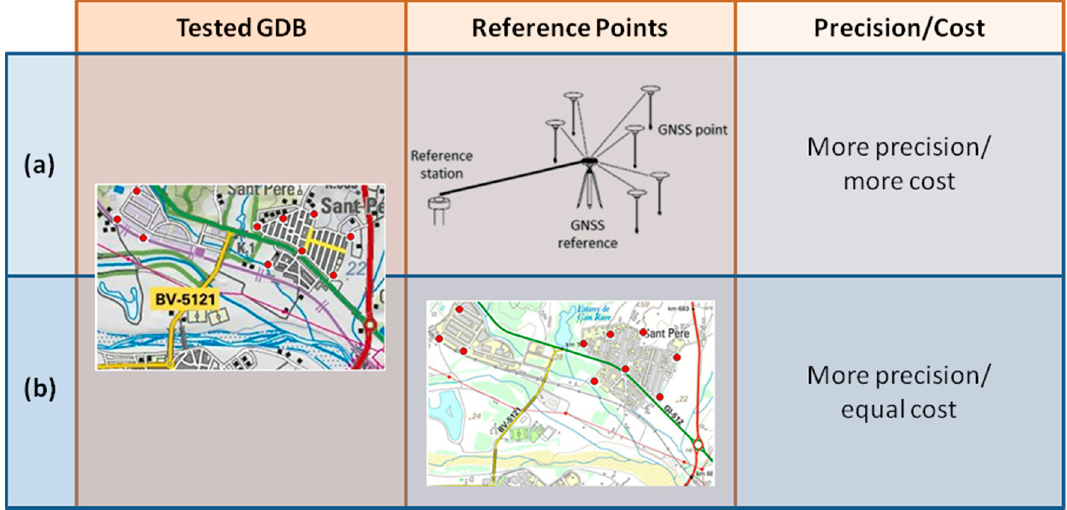
Figure 1. ( a ) Traditional points-based methods of positional quality assessment and ( b ) the new approach based on automated positional assessment. GBD, Geospatial Databases.